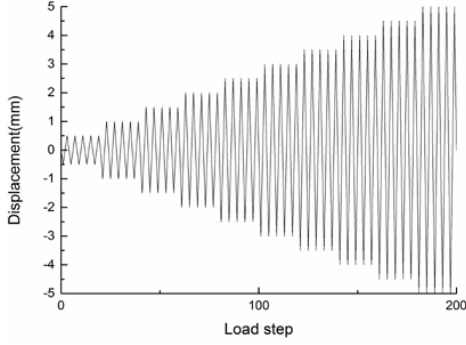
Figure 3. Load–displacement curve.